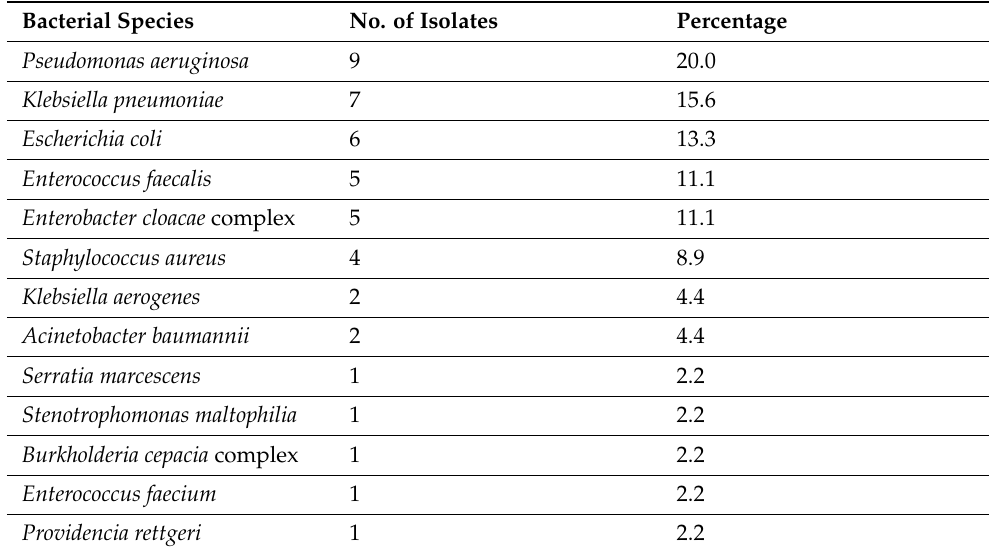
Table 2. Bacterial pathogens causing